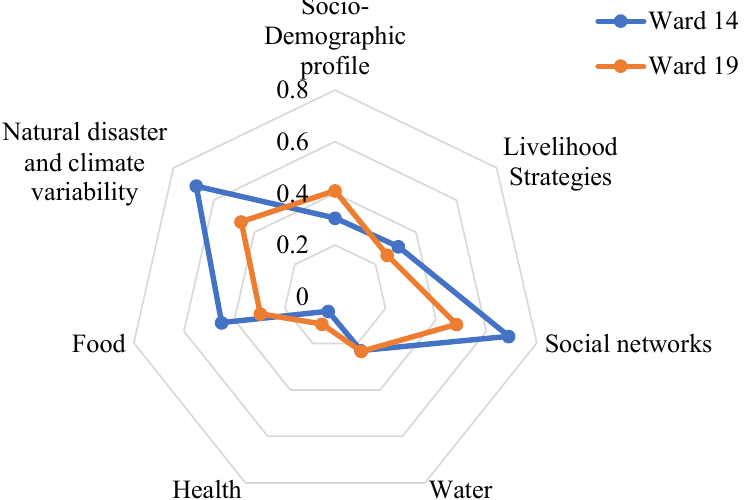
Figure 2. Spider diagram of the seven major components of the livelihood vulnerability index (LVI) in wards 14 and 19, Chivi district.